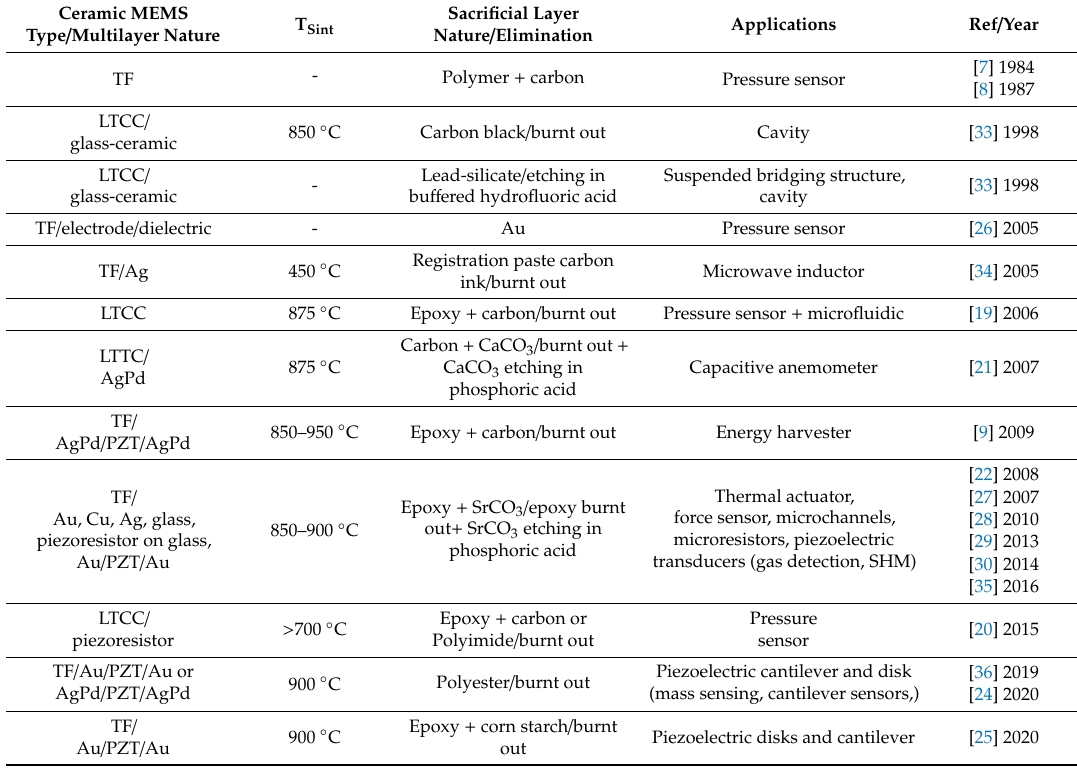
Table 1. Key process-related characteristics distinguishing ceramic MEMS using the sacrificial layer process and corresponding applications (TF = thick-film and LTCC = low-temperature co-fired